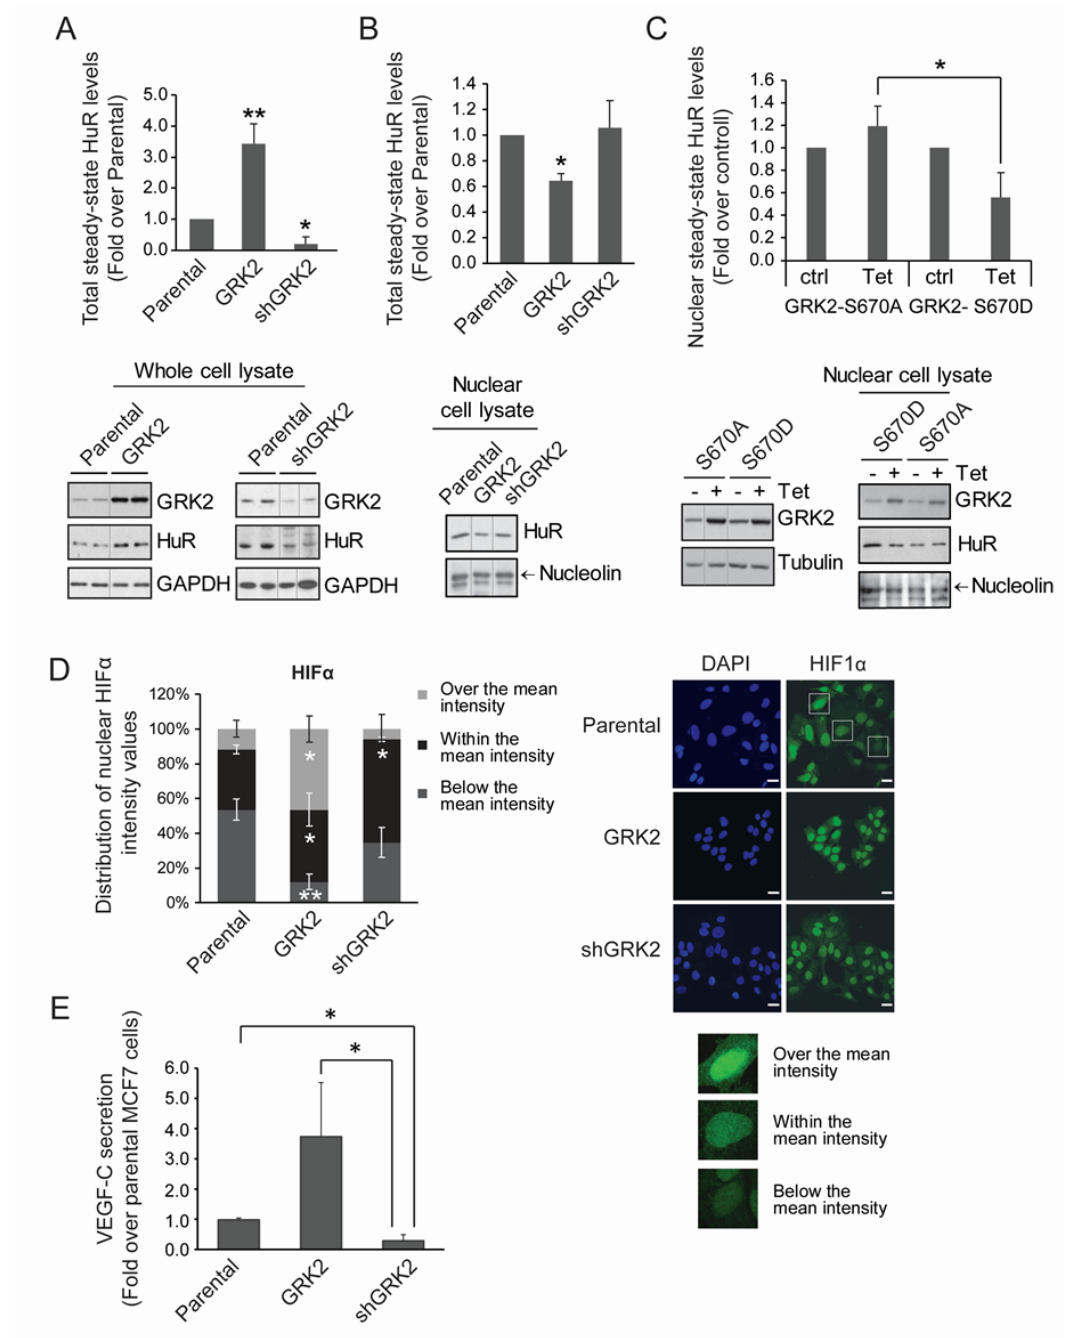
Figure 5. GRK2 modulates HuR levels and cytoplasmic shuttling, HIF1-α distribution, and VEGF-C secretion in luminal breast cancer cells. ( A , B ) Whole lysates or nuclear extracts from MCF7 cells stably expressing GRK2-wt or shGRK2 were used to analyze the HuR levels by immunoblot. Values are mean ± SEM from 3–4 independent experiments. * p < 0.05 ** p < 0.01 (Student’s t -test). Representative blots with loading controls are shown. ( C ) MCF7 stable inducible cell lines were treated with tetracyclin (Tet) to induce the expression of the indicated GRK2 mutants. HuR nuclear levels were analyzed by immunoblot. Values are mean ± SEM from two independent experiments. * p < 0.05 (Student’s t -test). Representative blots with loading controls are shown. ( D , E ) HIF1-α distribution and VEGF-C secretion levels were analyzed in parental MCF7 cells or in derived cells lines stably overexpressing GRK2 or a silencing construct (shGRK2) of the kinase. ( D ) HIF1-α and DAPI staining was analyzed by immunofluorescence; distribution of intensity values is shown. Values are